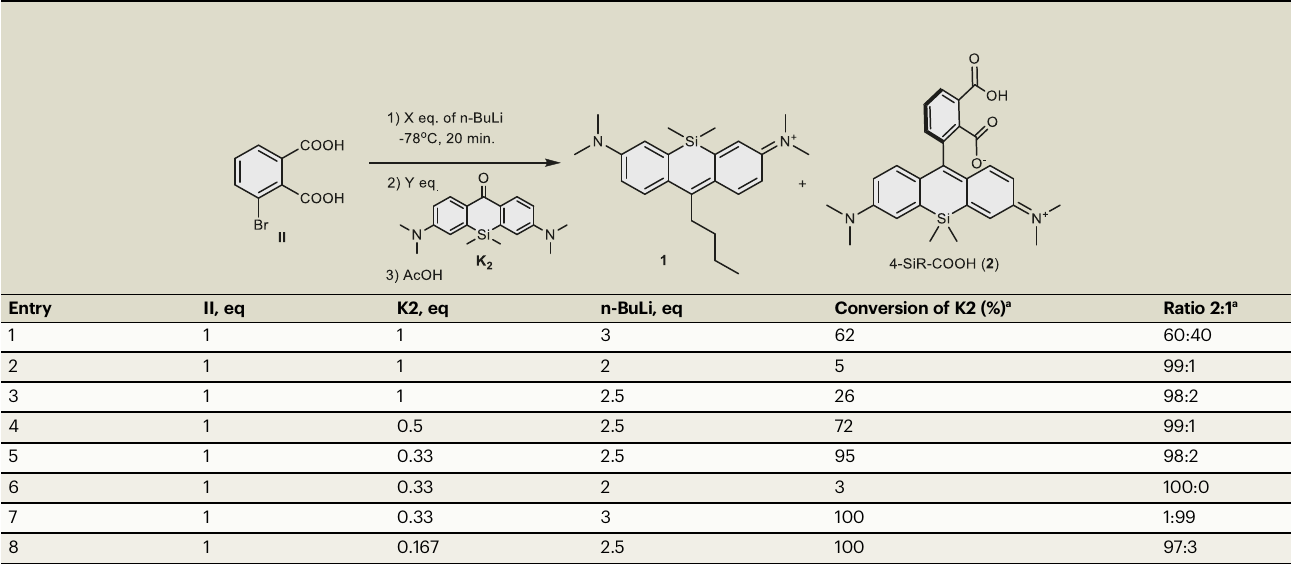
Table 2 | Optimization of nucleophilic addition reaction conditions to silaxanthone